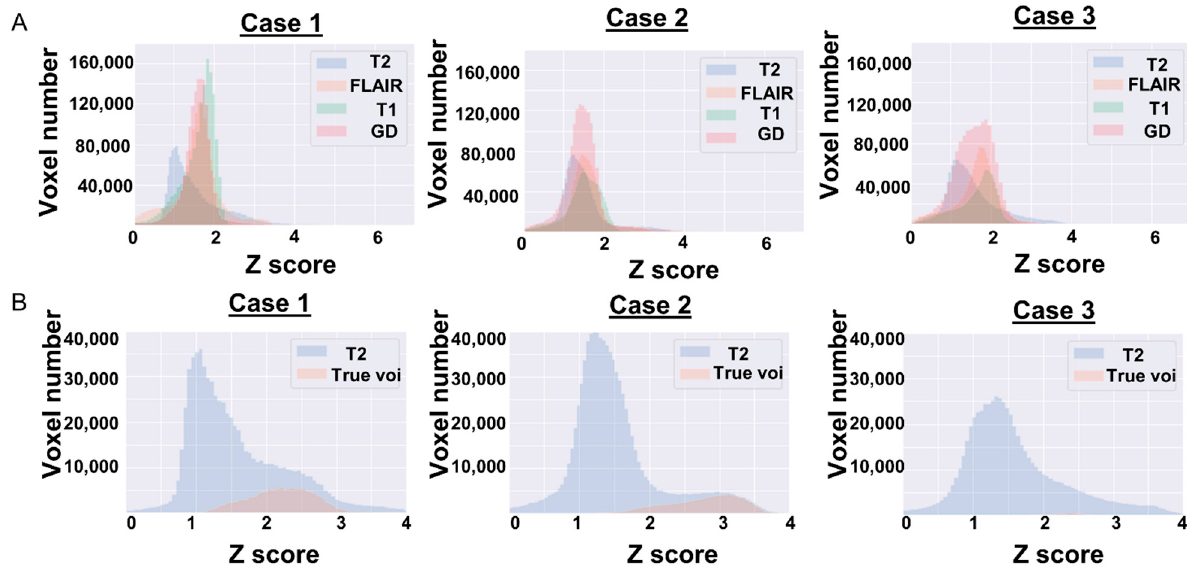
Figure 5. The results of comparison of image types in Case 1 from the BraTS dataset and Case 2 and Case 3 cases from the JC dataset are shown in histograms. The horizontal axis of the histogram represents the voxel value converted into a Z-score, and the vertical axis represents the number of voxels. ( A ) Each color represents image types. The GdT1 part of histograms of Case 1 and Case 2 have one peak around 1.8, however that of Case 3 has no peak. ( B ) The image histograms show the relationship between the T2 image (equivalent to the slice corresponding to the VOI) and true VOI. Blue histogram represents the T2 image, and orange represents true VOI. The VOI part of histograms of Case 1 and Case 2, located right edge (around 3), occupied a relatively large portion. But that of Case 3 was located central (around 2.5) and had a small portion.